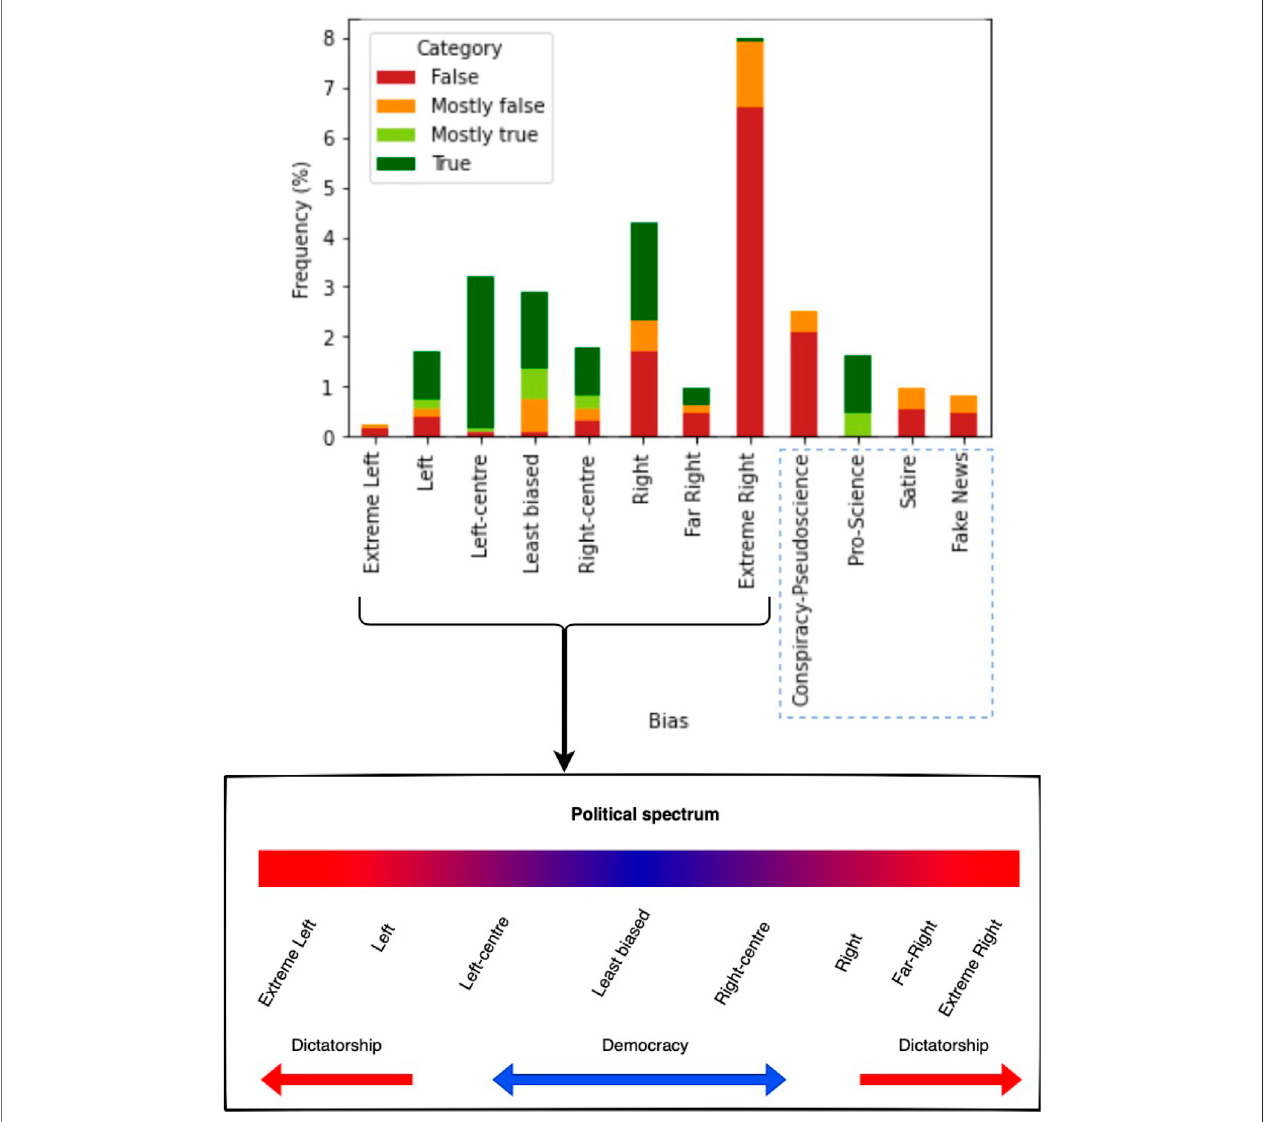
FIGURE 7 | Political spectrum in news sources in the dataset. The x -axis displays the political leaning within one of the following categories (political spectrum): ExtremeLeft,Left,Left-centre,Leastbiased,Right-centre,Right,FarRight,andExtremeRight.AccordingtotheinformationprovidedbyMediaBias/FactCheckwebsite, thefollowingfourextracategoriesarealsoidenti fi edanddisplayed:Conspiracy-Pseudoscience,Pro-Science,Satire,andSourcePendingReview.The y -axisreportsthe frequencyasthepercentageofthenumberofnewssourcesinthedifferentgroups.Conservativeandextremelyconservativenewssourcesaremostlyidenti fi edas unreliable ( “ False ” and “ Mostly False ” ) than other